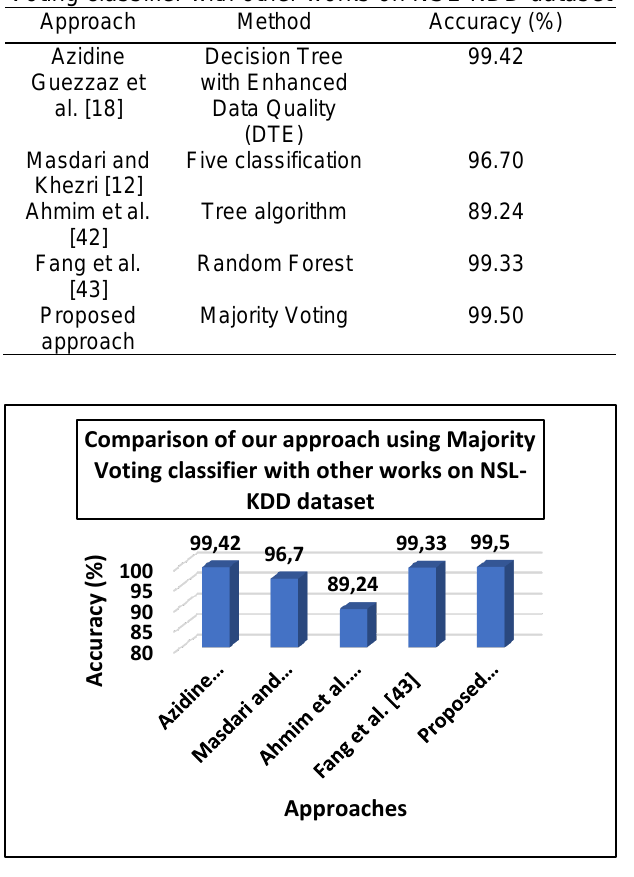
Figure 3. Comparison of our approach using Majority Voting classifier with other works on NSL-KDD